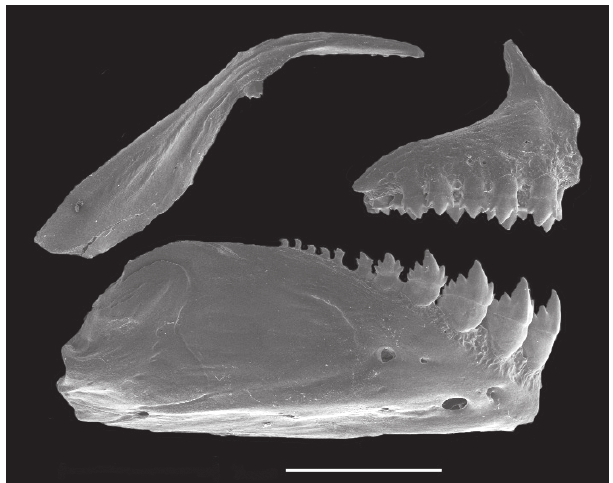
Fig. 3. Astyanax obscurus , MCP 26125, 65.5 mm SL. SEM image of upper and lower jaws, right side. Scale bar = 2 mm.